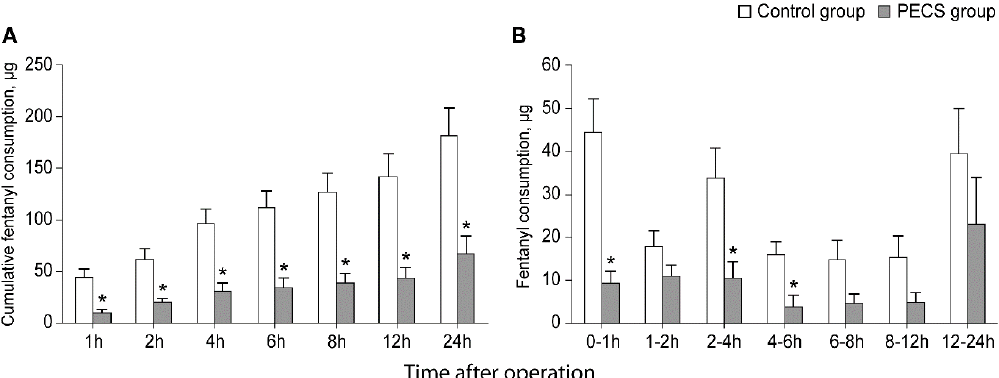
Figure 2. Dose of cumulative fentanyl consumption ( A ) and fentanyl consumption during 24 h after operation ( B ). Values are presented as mean ± standard error. PECS, pectoralis nerve II block. * Bonferroni corrected p < 0.05 versus the control group.